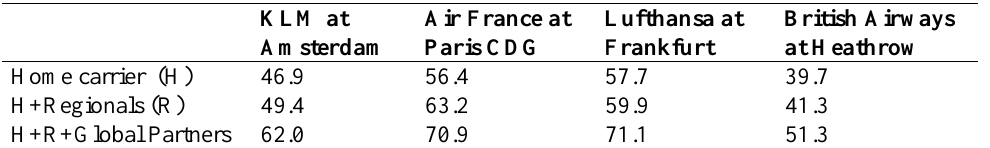
Table 1. Concentration at selected European hubs (% in total scheduled flight movements) in 2004 KLM at Air France at Lufthansa at British Airways Amsterdam Paris CDG Frankfurt at Heathrow Home carrier (H) 46.9